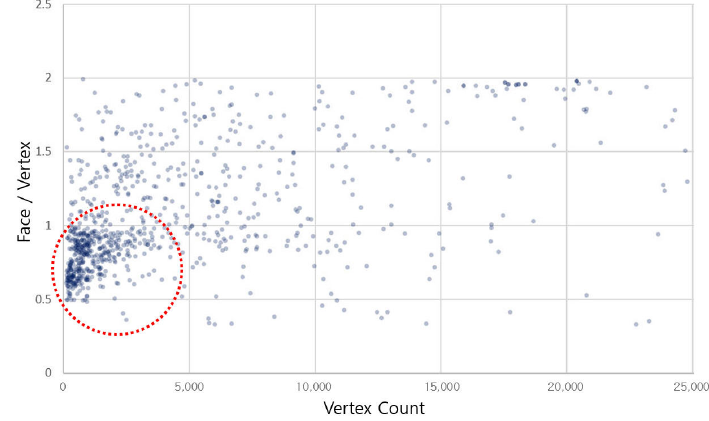
Figure 14. Face/vertex ratio according to vertex